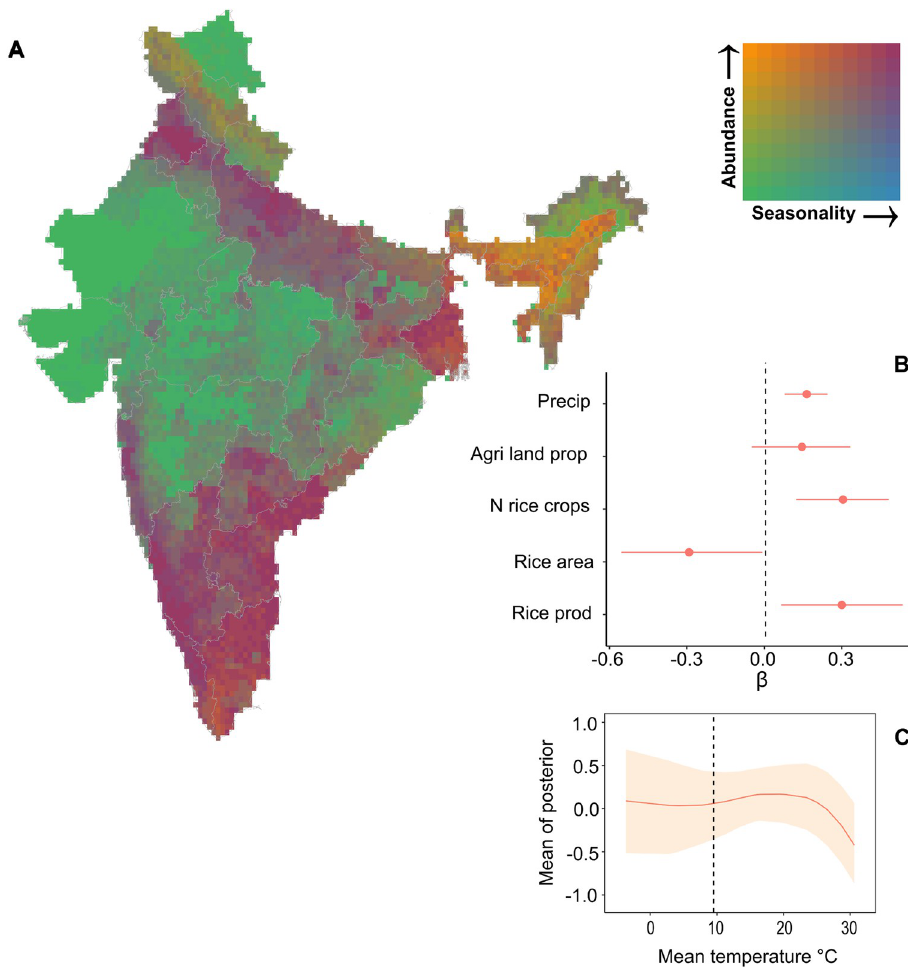
Fig 2. Spatiotemporal correlates of JE vector abundance across India averaged over the period 1990–2012. Map to show predicted C . tritaeniorhynchus abundance (maximum annual value) and vector seasonality (intra-annual variance in abundance) (A). These measures were calculated from the scaled abundance predictions and ranged from 0 to 7 logscale for maximum abundance and 0 to 3 logscale for seasonality. The map displays areas of high perennial vector abundance as orange, high seasonal vector abundance as pink, low perennial vector abundance as green and low seasonal vector abundance as blue. The fixed-effect parameter estimates and 95% credible intervals for the joint likelihood model (B) show that vector abundance is strongly influenced by climatic and land use variables. The nonlinear relationship between monthly mean temperature and vector abundance for the observed range of temperatures (C) where 95% CI is shown shaded and peaks at around 23˚C and then declines. The reported thermal minima (9.5˚C) for important Culex species life history traits [19] is indicated with a dashed line. Source of base layer